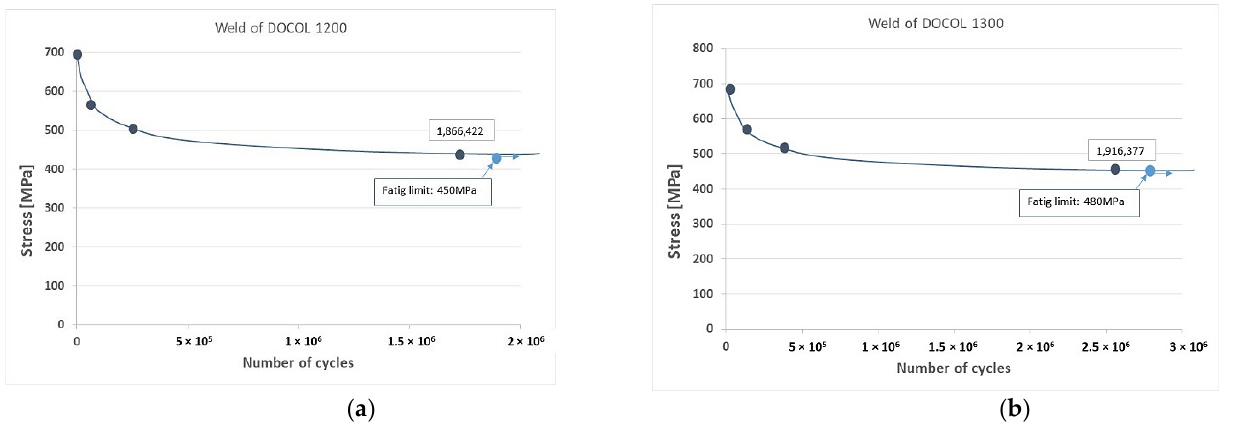
Figure 3. Fatigue test results: ( a ) weld of DOCOL 1200; ( b ) weld of DOCOL 1300. To sum up, it should be stated that the test results indicate that the biggest disadvan- tage of the obtained connections is the inability to obtain similar strength properties in